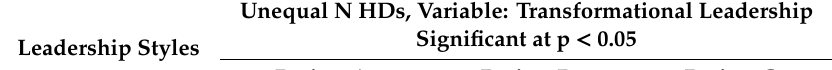
Table 5. Post hoc Tukey (HDS) Test for significant di ff erences in transformational leadership amongst the three